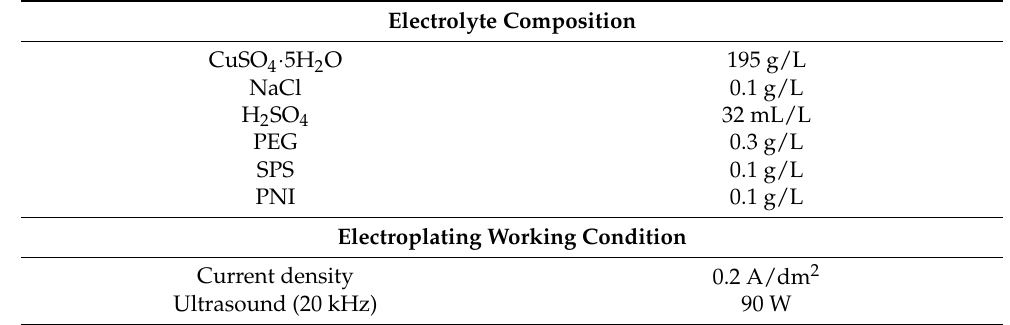
Table 1. Electrolyte composition and working conditions.